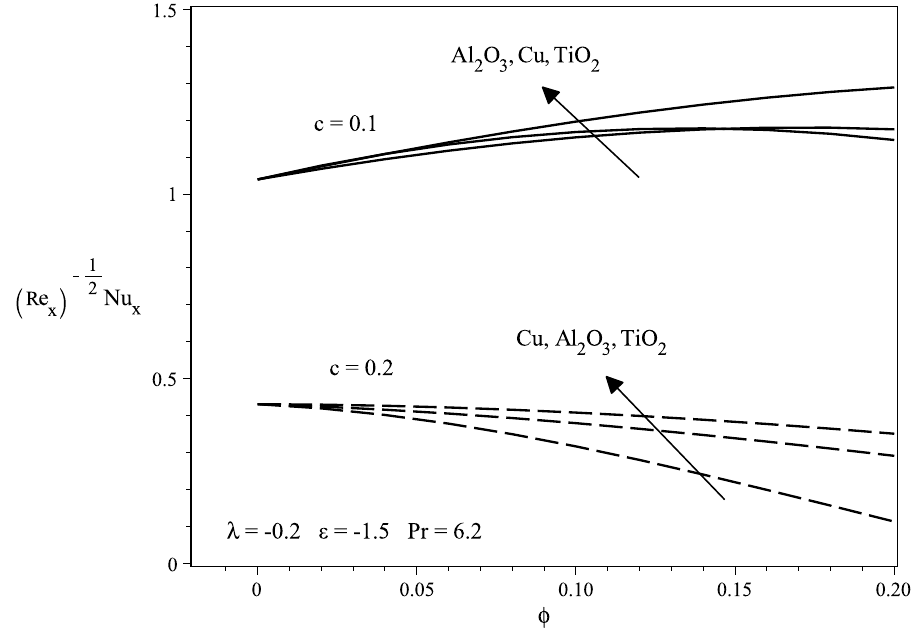
Figure 9. Variation of local Nusselt numbers with nanoparticle volume fraction φ for different nanoparticles when c = 0.1 and c =